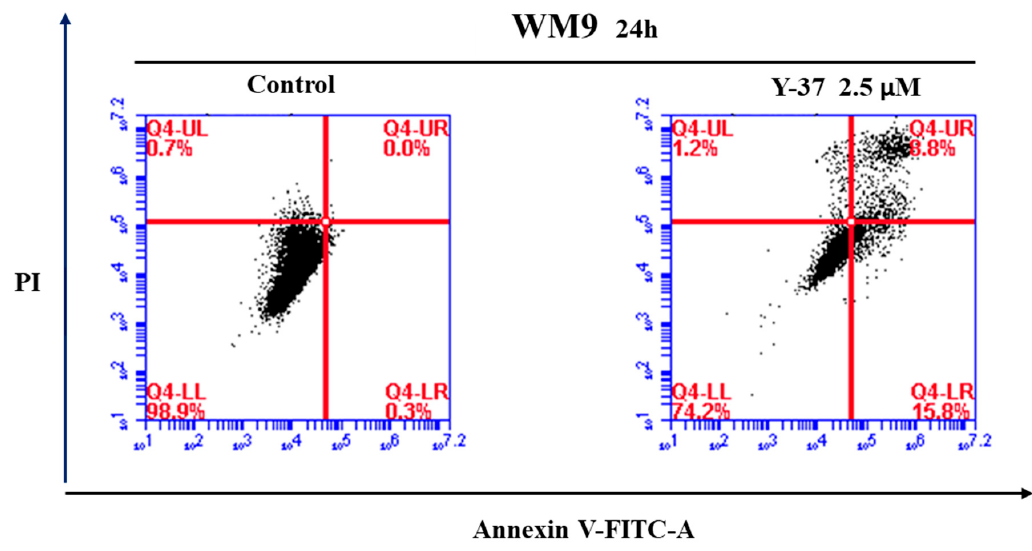
Figure 2. Compound 4g induced apoptosis in WM9 cells. WM9 cells were stained with Annexin V-FITC and PI by incubating at room temperature for 15 min after treated cells with 2.5 µM 4g for 24 h. Finally, apoptosis analysis was carried out by flow cytometry. 2.2.3. The Fangchinoline Derivative 4g Affects the Protein Levels of Apoptosis Indicators in